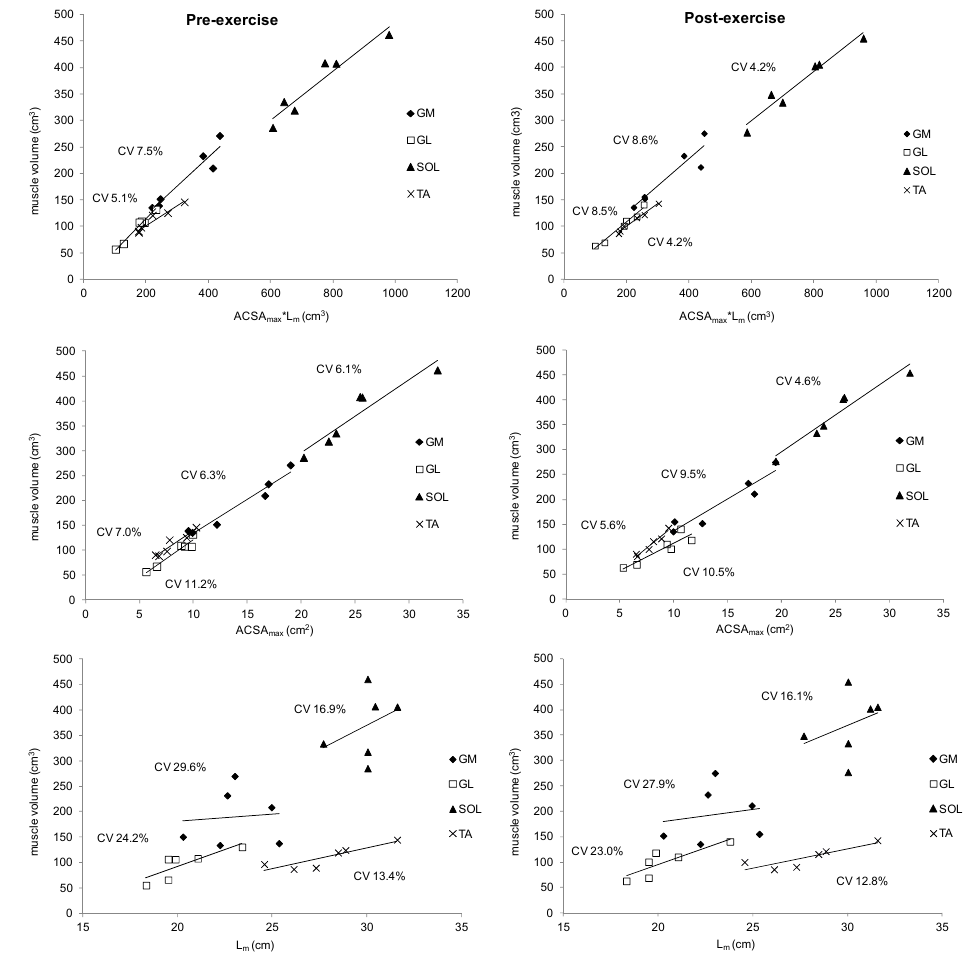
Figure 4. Inter-subject variability regarding muscle shape. Measured values for the muscle volume and the product of ACSA max and muscle length ( first line ), ACSAmax ( second line ) and muscle length ( third line ) before and after the exercise. The values for the CV are presented near the regression lines and also in Table 3.